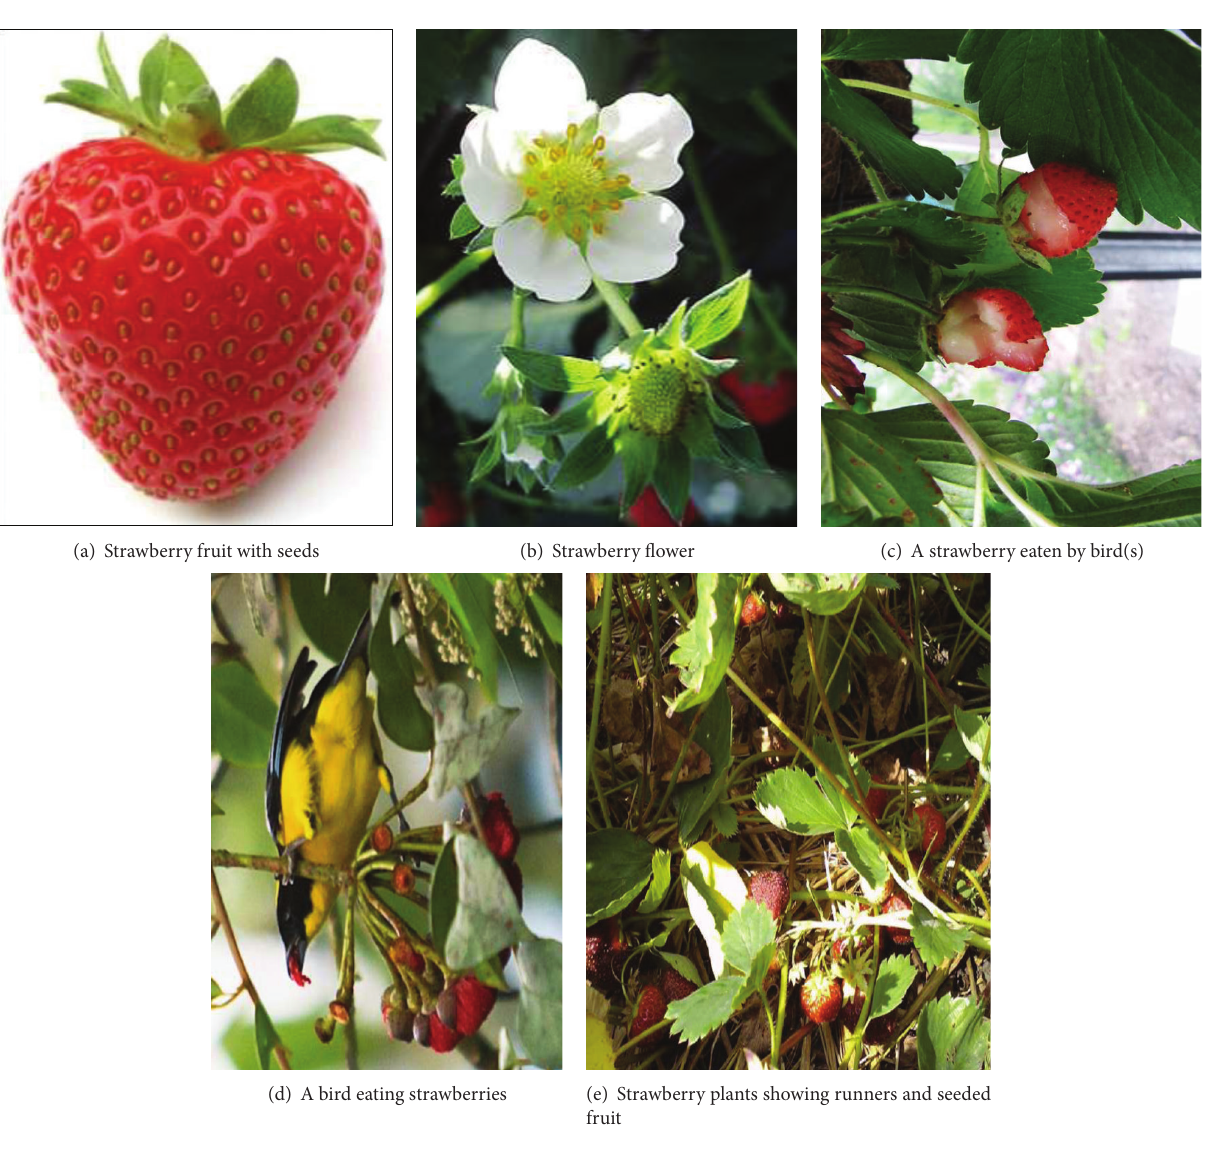
Figure 1: Strawberry plant propagation: through seed dispersion